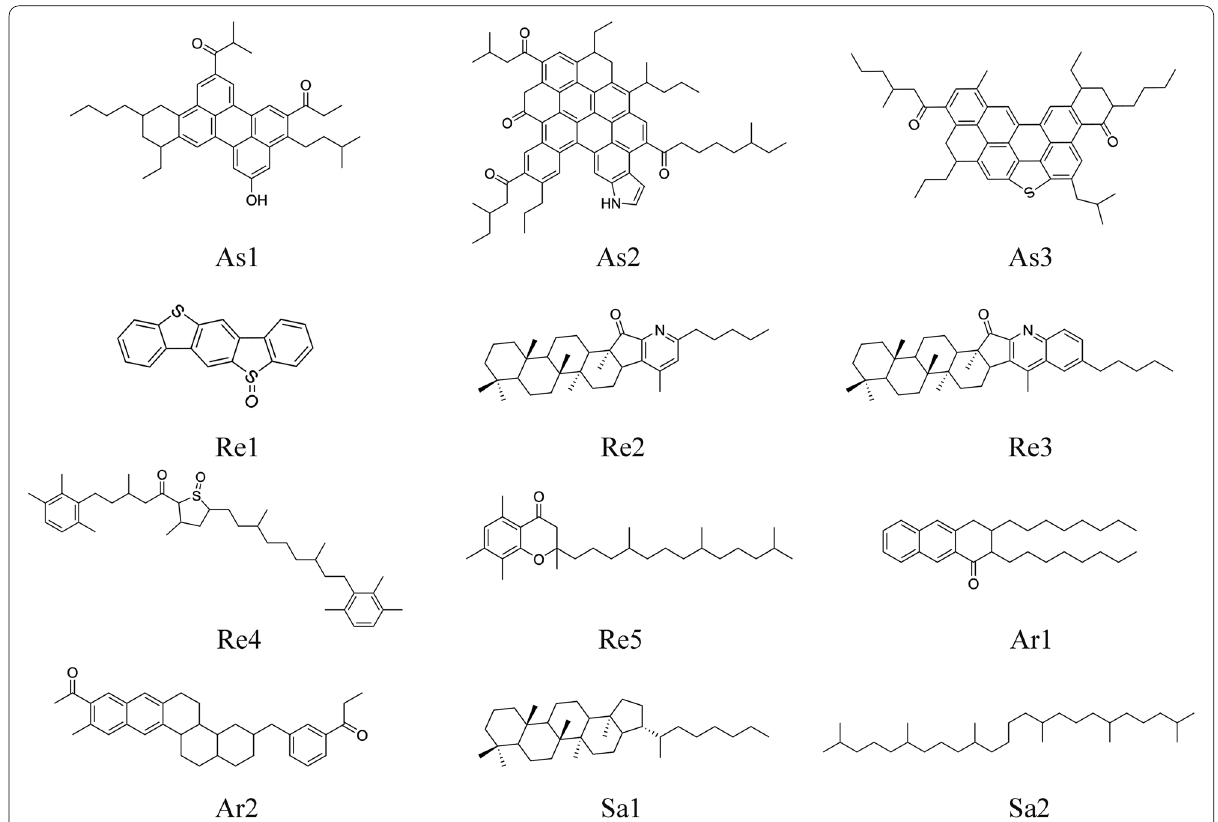
Fig. 2 12-Component Molecular Structures of Short-Term Aged Asphalt